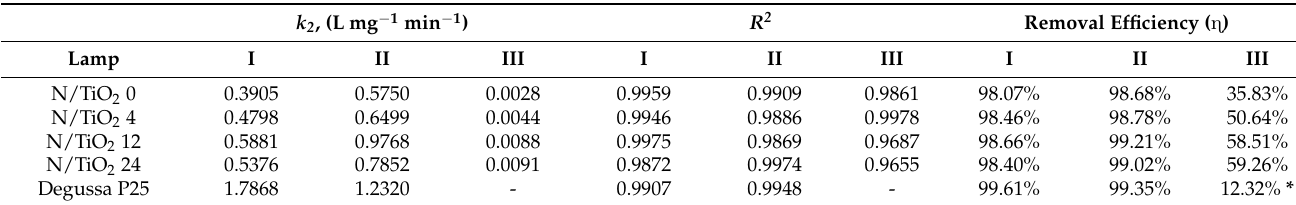
Table 5. Parameters obtained from the CIP degradation under UVA (lamp I), Solar light simulator (lamp II), and warm visible light (lamp III) fitted to a pseudo-second-order kinetic model, and removal efficiency of N/TiO 2 materials.